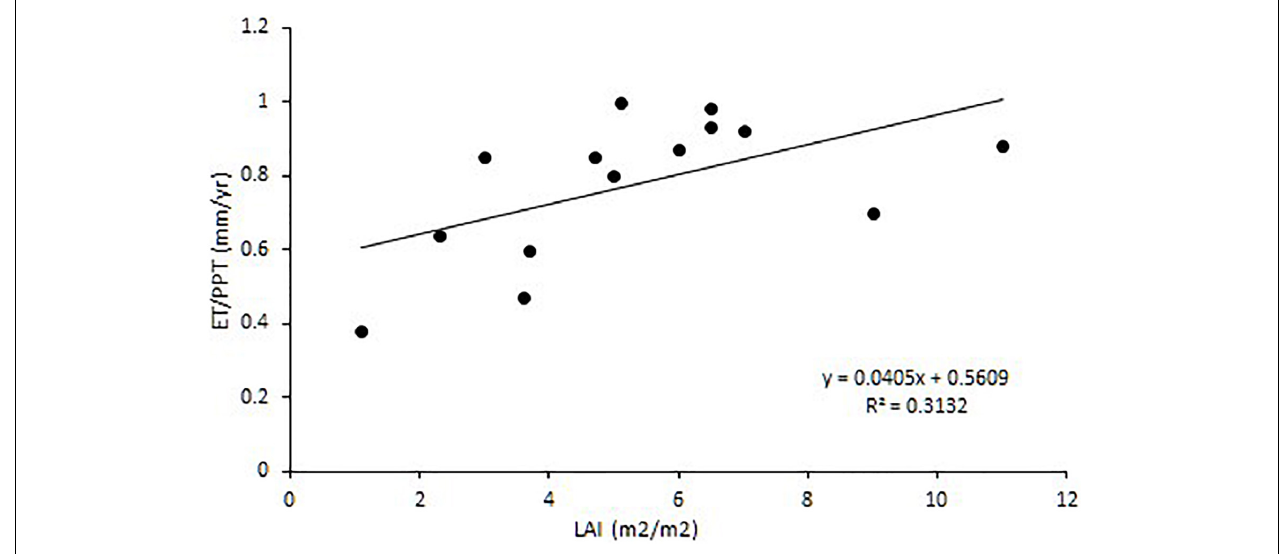
FIGURE 2 | Ratio of evapotranspiration by precipitation as a function of Stand Leaf Area Index (LAI) across the Southern United States (McLaughlin et al.,